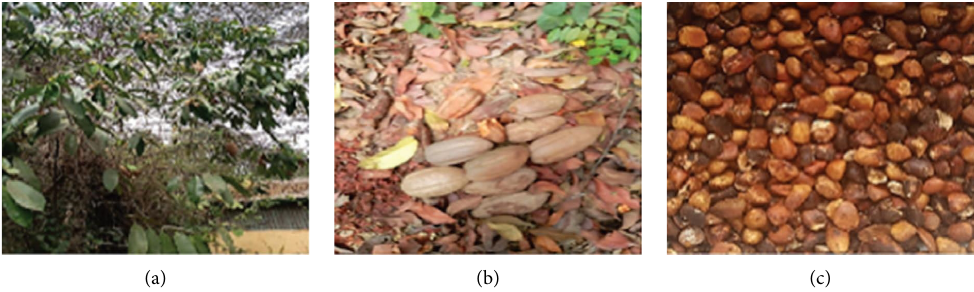
Figure 1: Pictures showing (a) A. foribunda tree, (b) matured A. foribunda fruits, and (c) dried A. foribunda